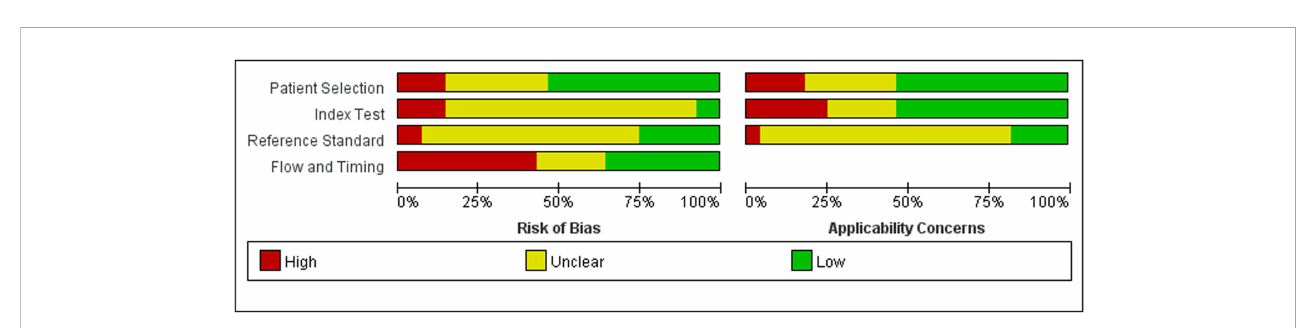
FIGURE 3 Risk of bias and applicability concerns graph: review authors ’ judgements about each domain presented as percentages across included